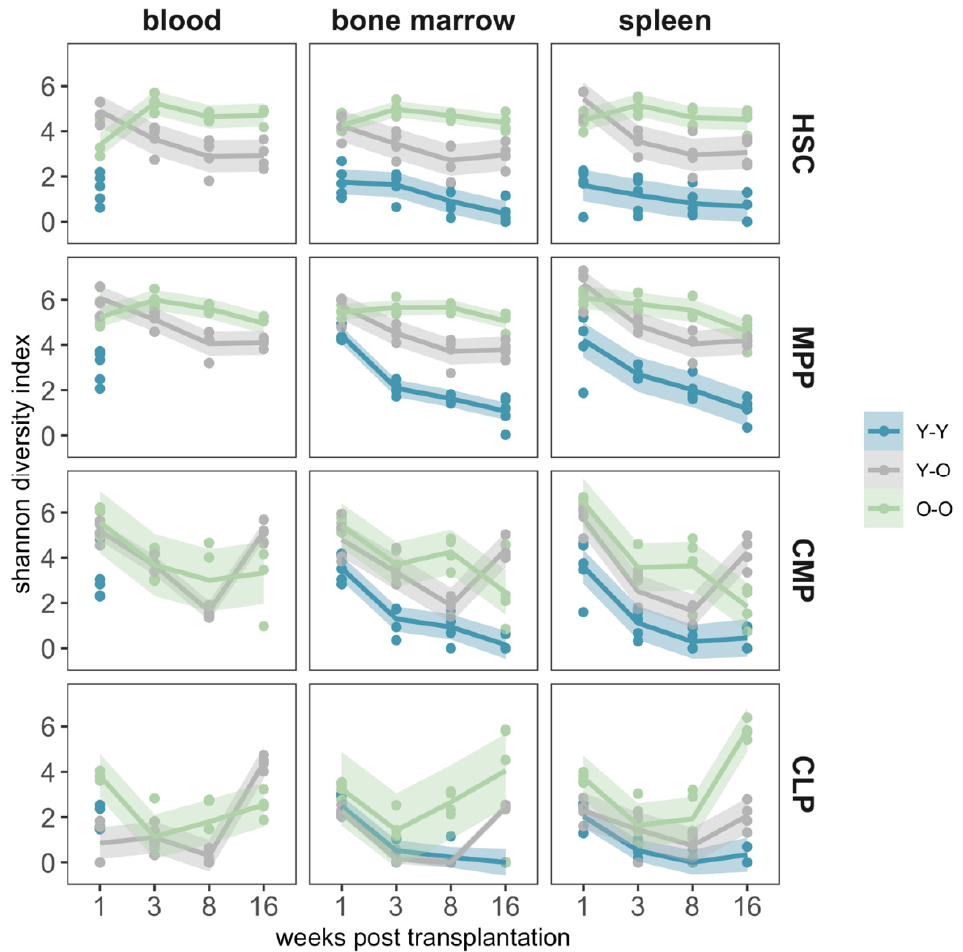
Figure 5. Clonal diversity measured by the Shannon index. We calculated the Shannon index (36, 48) to determine the clonal diversity in peripheral blood, bone marrow, and spleen. A high Shannon index refers to a polyclonal situation, whereas a lower index reflects a loss of clones or the emergence of clonal dominance. A fitted local polynomial regression curve (including a 95% confidence interval) was used for a better representation. Blue data represent the Y-Y experimental setting, grey data represent the Y-O experimental setting, and light green data represent the O-O experimental setting.